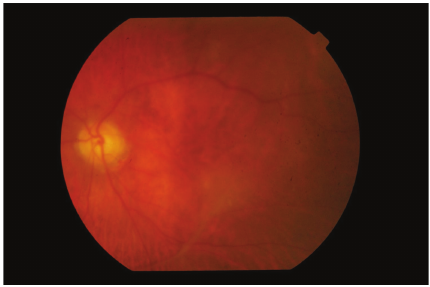
Figure 2: Contralateral fundal photography.